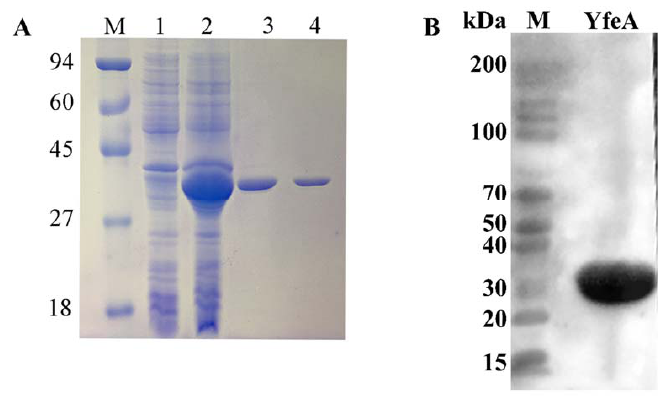
the expression and purification of YfeA. M: protein marker; 1: BL21 containing pET-28a; 2: supernate of BL21 containing YfeA ‐ pET ‐ 28a after inducing and disruption; 3: the purified YfeA protein; 4: the purified YfeA protein (dialyzed, ultra ‐ filtrated, and LPS ‐ removed). ( B ) Detection of the specificity of purified YfeA using WB assay. M: protein marker; YfeA: the purified YfeA protein (dialyzed, ultra-filtrated, and LPS-removed).